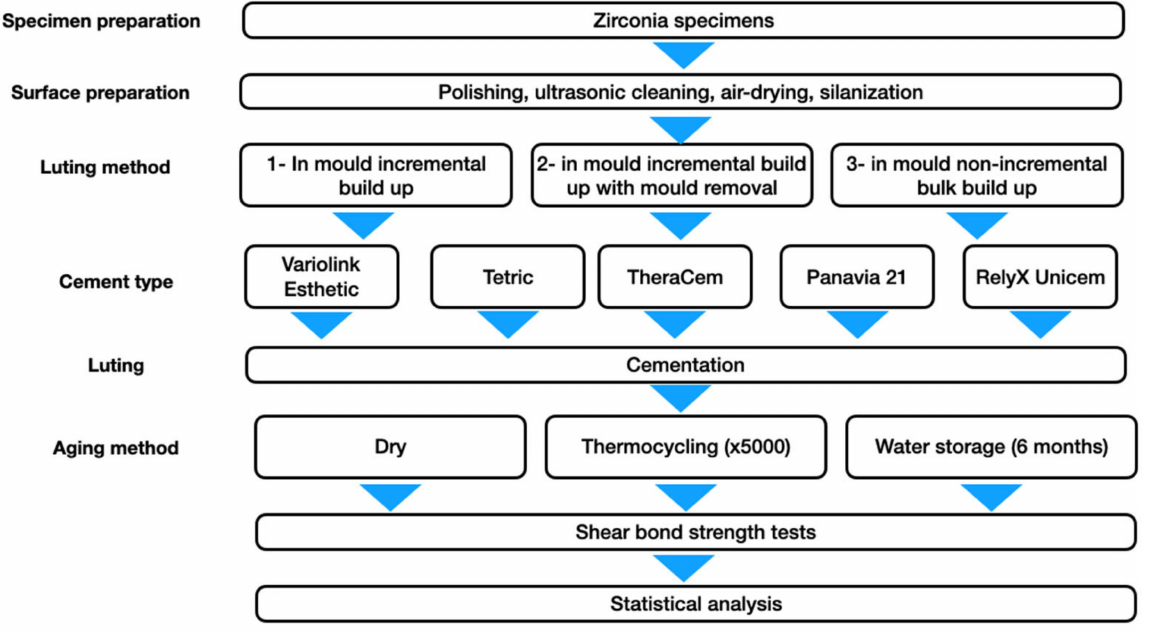
Figure 1. Flowchart outlining experimental arrangement and alignment of groups.